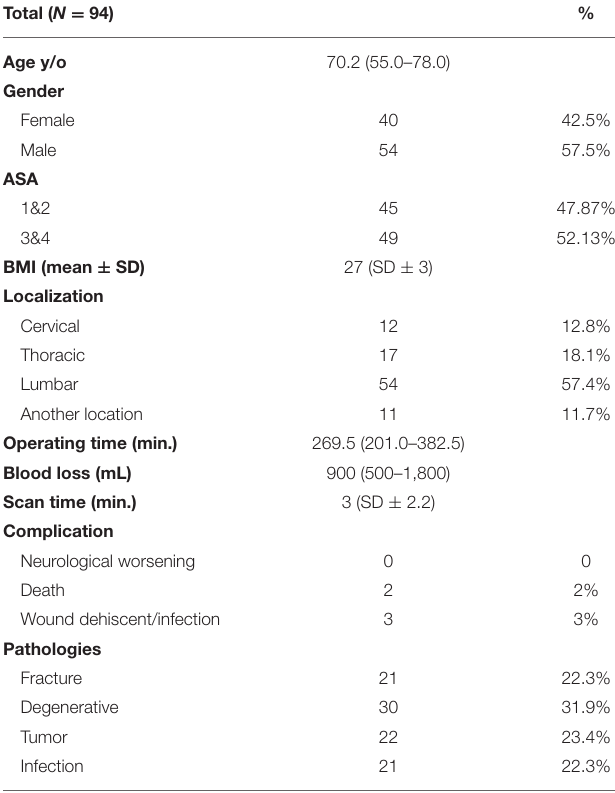
TABLE 1 | Baseline data.